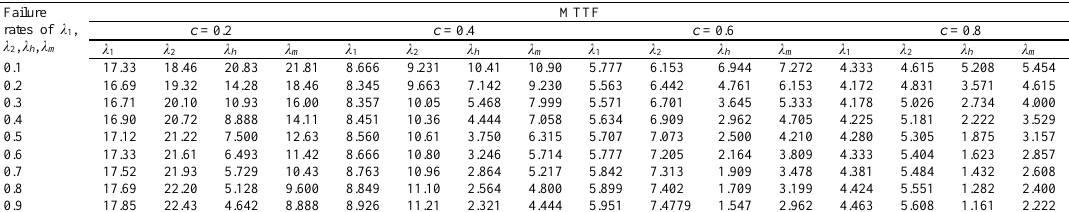
Table 13. MTTF of the system with copula-